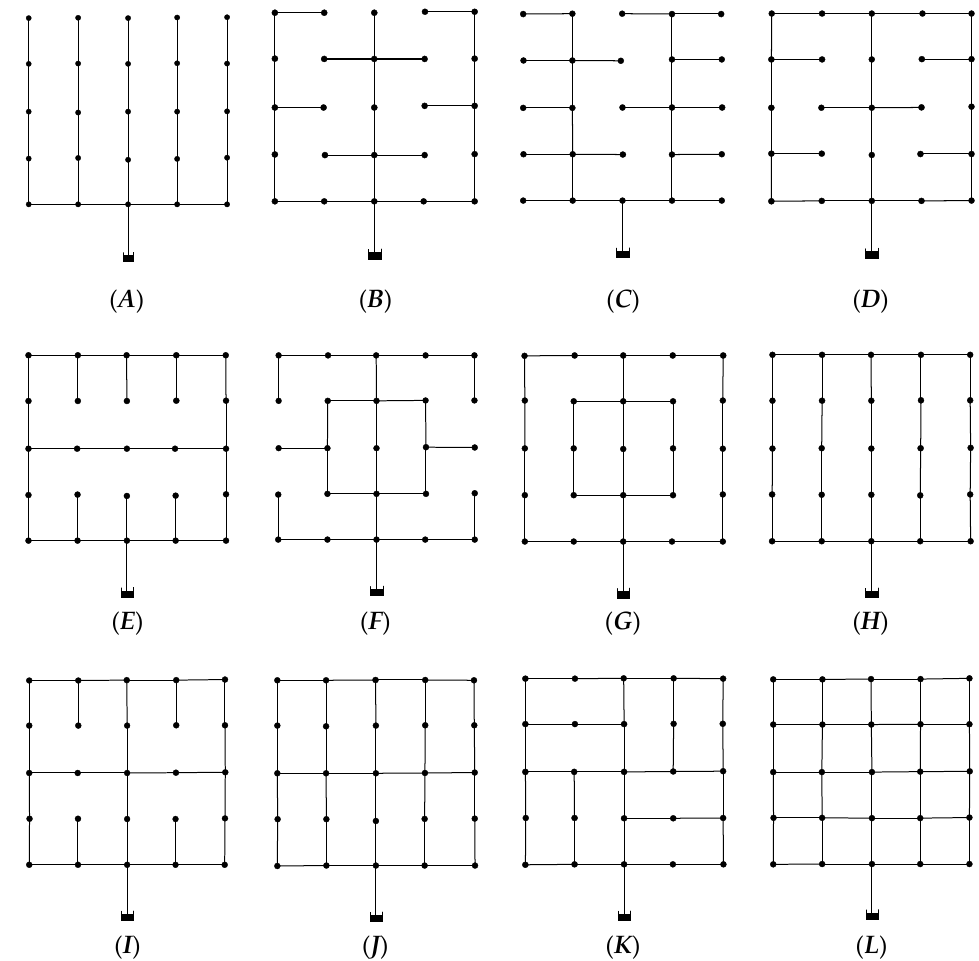
Figure 1. Geometric structures of the model grid network ( A – L ). Total pipe lengths (m): ( A ): 2400; ( B ): 2400; ( C ): 2400; ( D ): 2600; ( E ): 2600; ( F ): 2600; ( G ): 2700; ( H ): 2800; ( I ): 2900; ( J ): 3200; ( K ): 3200; and ( L ): 4000 m.